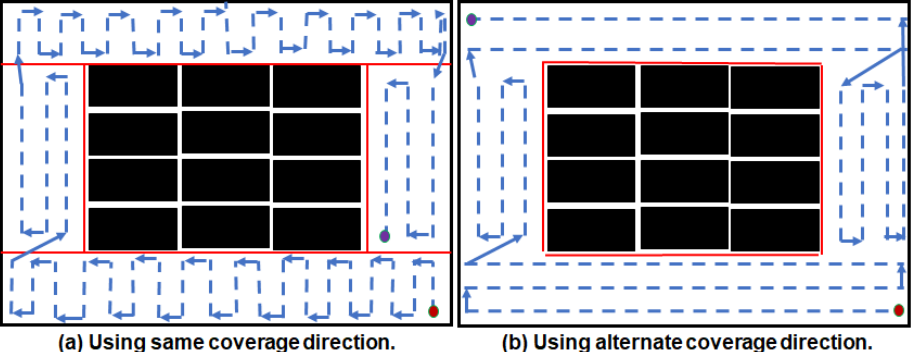
Figure 13. Improved path quality using the alternate ( b ) coverage direction compared to same ( a